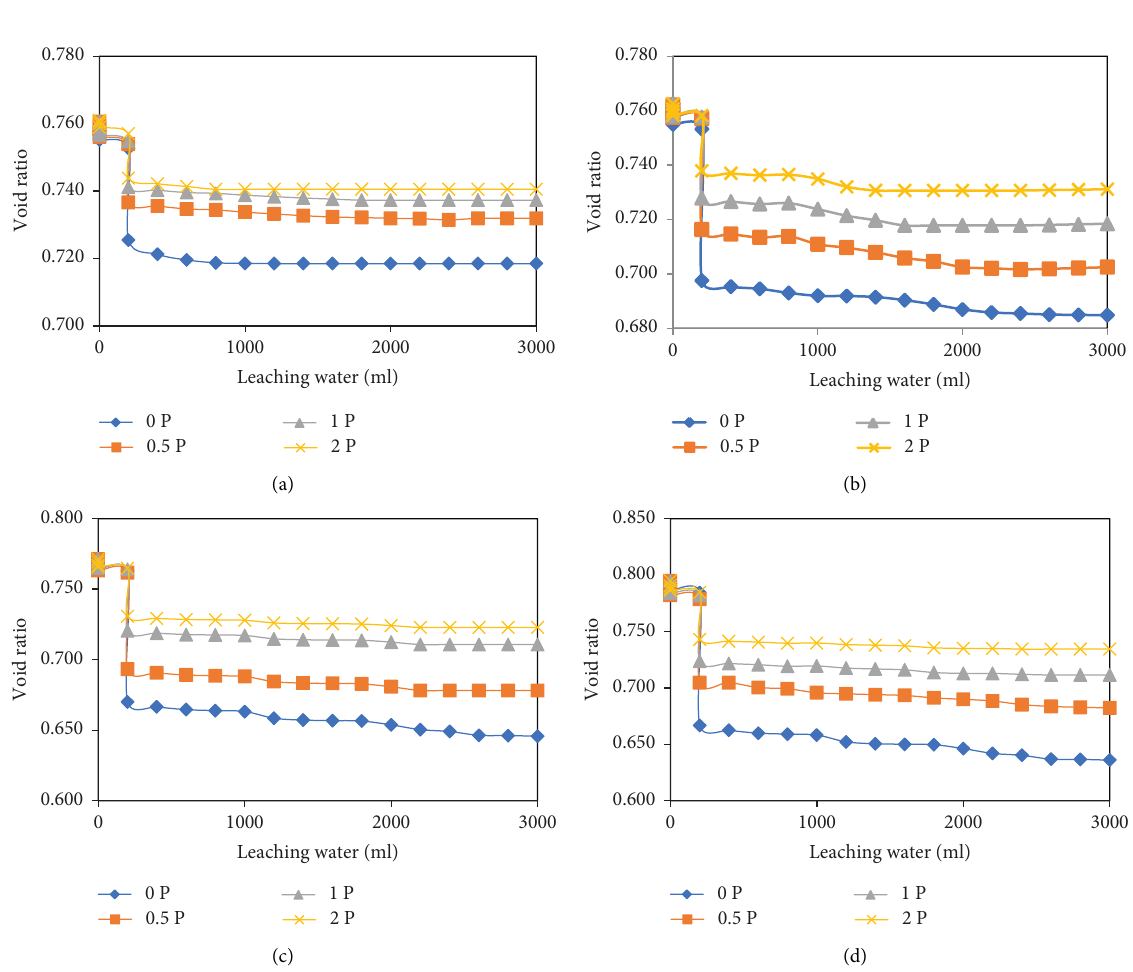
Figure 10: Te relationship between void ratio and leachate water for pectin-treated soil samples (a) soil 1, (b) soil 2, (c) soil 3, and (d) soil 4. Table 5: Te collapse potential of samples before and after pectin treatment during the leaching process. Pectin